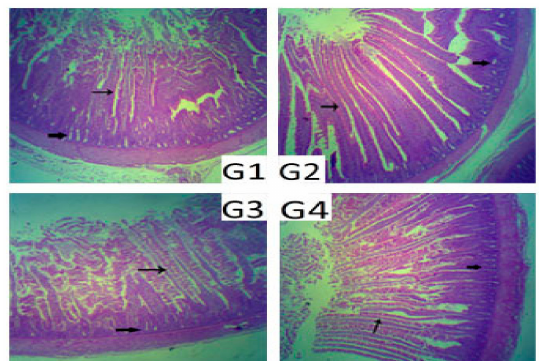
Figure 1. Histological examination of duodenum samples stained with H&E; ( G1 ) control ( × 40), ( G2 ) group 2 ( × 40), ( G3 ) group 3 ( × 40), and ( G4 ) group 4 ( × 40). Small arrows point to intestinal villi. Large arrows point to intestinal crypts.